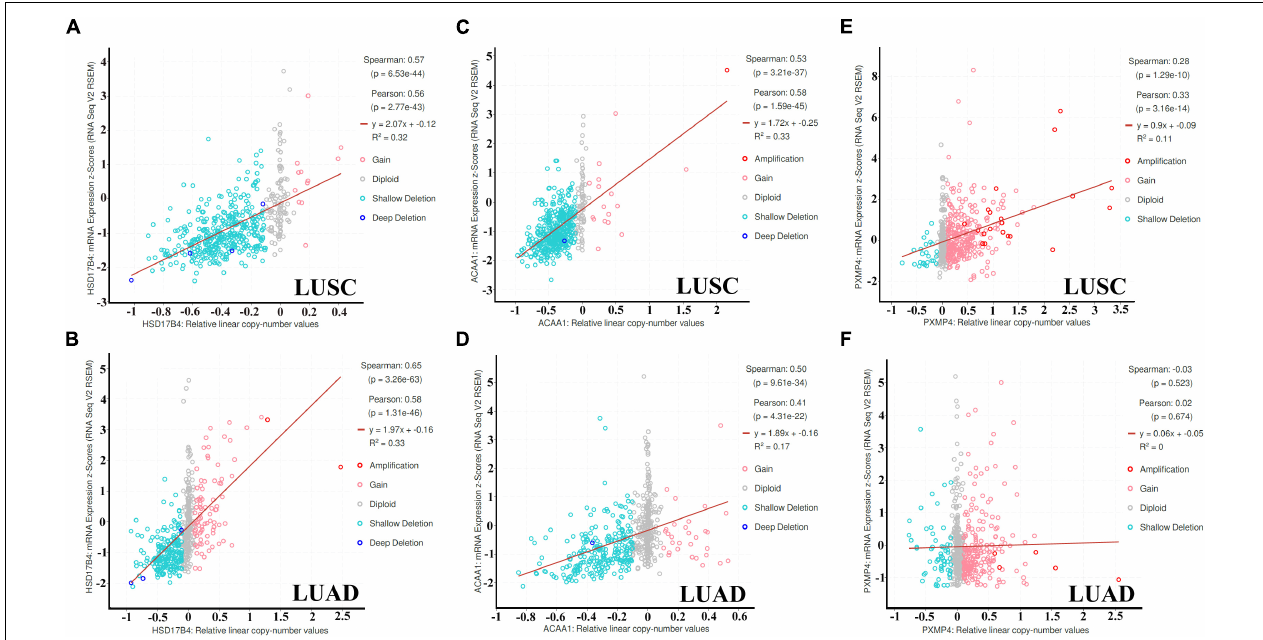
FIGURE 7 | Correlations between HSD17B4, ACAA1, and PXMP4 expression and their copy number value in NSCLC. (A,B) Significant positive correlation between HSD17B4 CNV and HSD17B4 expression in LUSC and LUAD,respectively. (C,D) Significant positive correlation between ACAA1 CNV and ACAA1 expression in LUSC and LUAD,respectively. (E) Significant positive correlation between PXMP4 CNV and PXMP4 expression in LUSC. (F) There was no significant correlation between PXMP4 CNV and PXMP4 expression in LUAD. NSCLC, non-small cell lung cancer; LUSC, lung squamous carcinoma; LUAD, lung adenocarcinoma. Spearman and Pearson correlation analyses were used and p < 10 − 5 was considered significant.